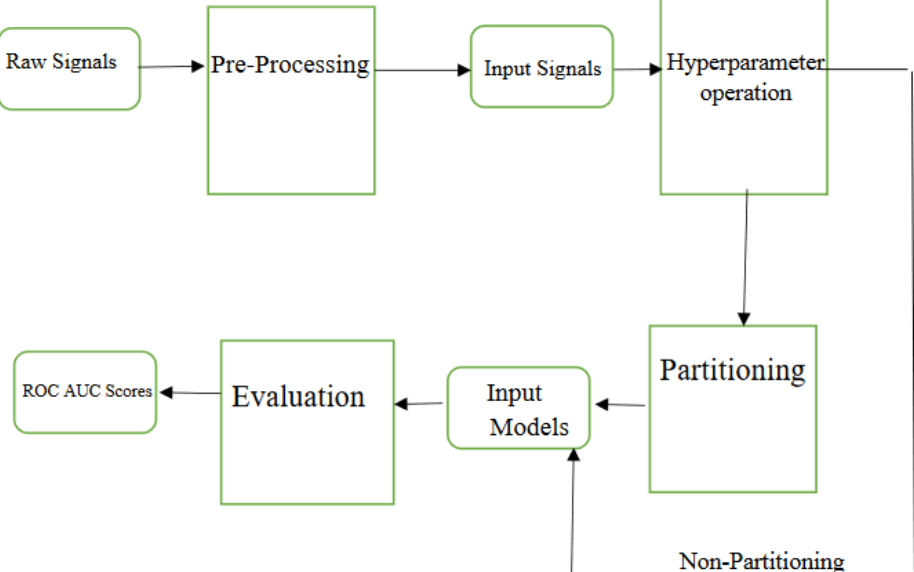
Figure 8. Engine vibration data were utilized to evaluate partitioning and non-partitioning abnor- mality identification systems.